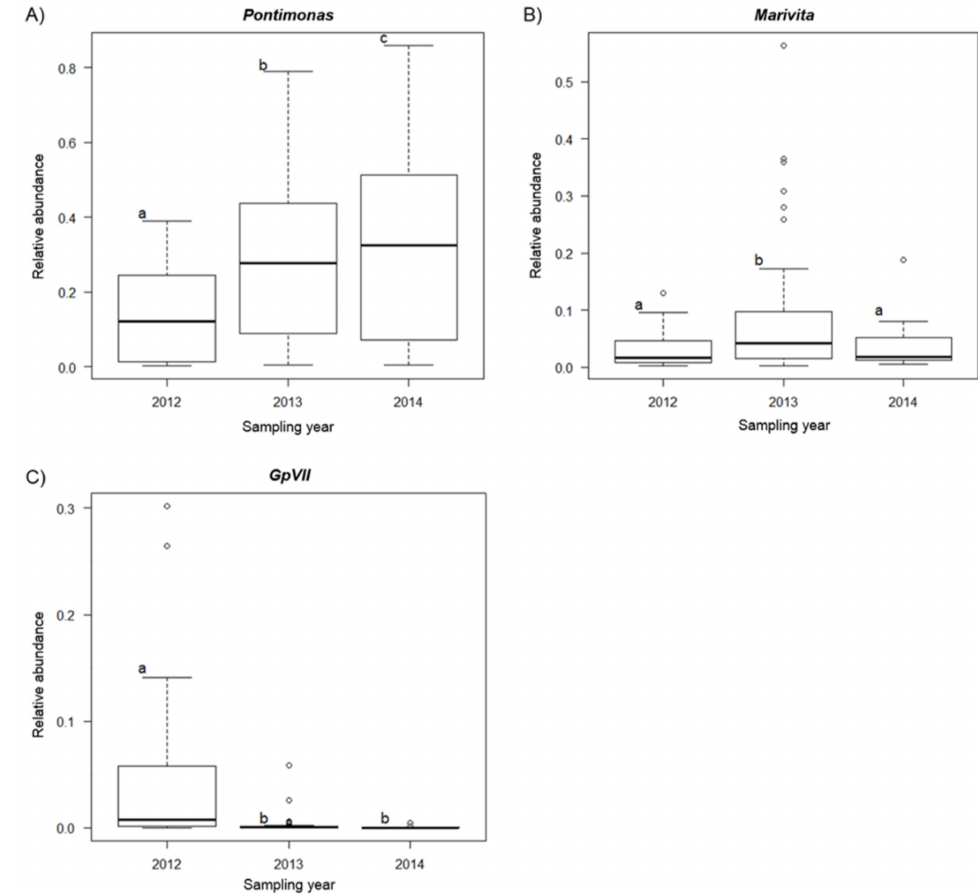
Figure 7. Box-whisker plot (GLM analysis) showing abundance variation of Pontimonas ( A ), Marivita ( B ) and GpVII ( C ) in relation to the sampling years. The thick lines represent the median, boxes’ upper and lower limits indicate the 25th and the 75th percentiles respectively, whiskers indicate the data that go beyond the 5th percentile (lower whisker) and the 75th percentile (upper whisker), and dots represent the outliers. Different letters indicate differences between the mean values of different